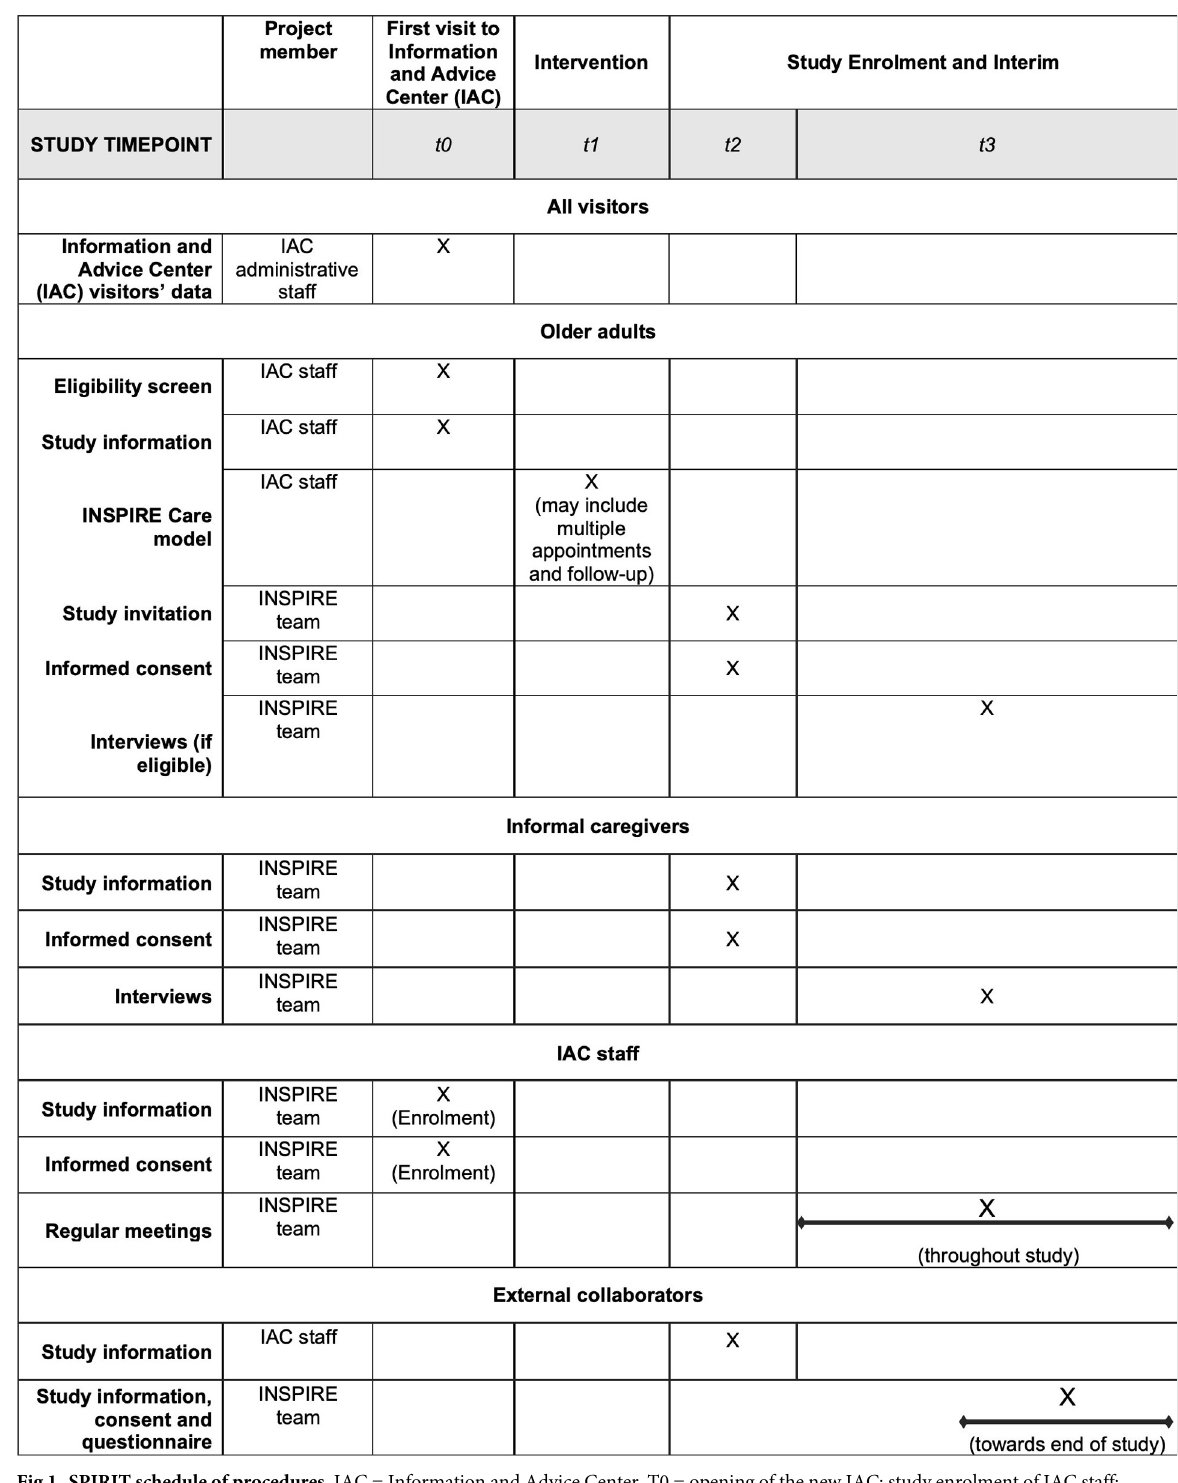
PLOS ONE | https://doi.org/10.1371/journal.pone.0278767 December21, 2022 6 /